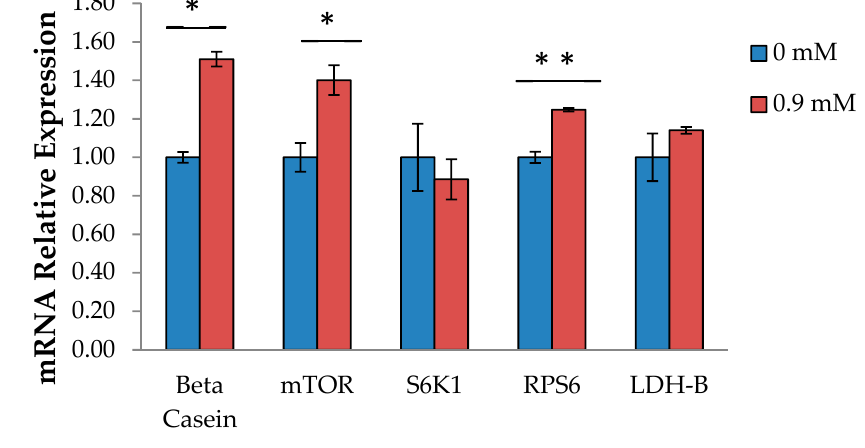
Figure 3. Changes in gene expression levels by addition of 0.9 mM L-Trp to MAC-T cells at 48 h. Analyzed by t -test between 0 and 0.9 mM L-Trp at 48 h: * p < 0.05, ** p < 0.01.